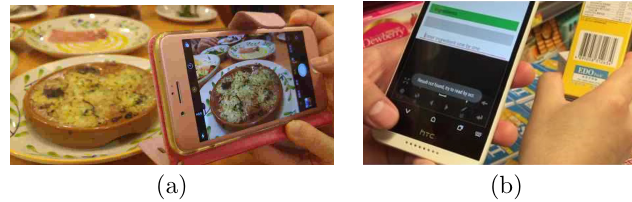
Figure 1. Usage scenario of our mobile app: (a) a user can keep track of his/her dietary by simply taking photo, our system understands the type of food consumed automatically, (b) a user can easily understand more on the ingredients of a food product by simple